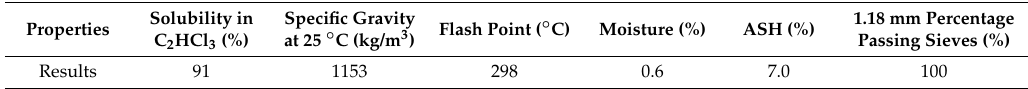
Table 2. The physical properties of rock asphalt.